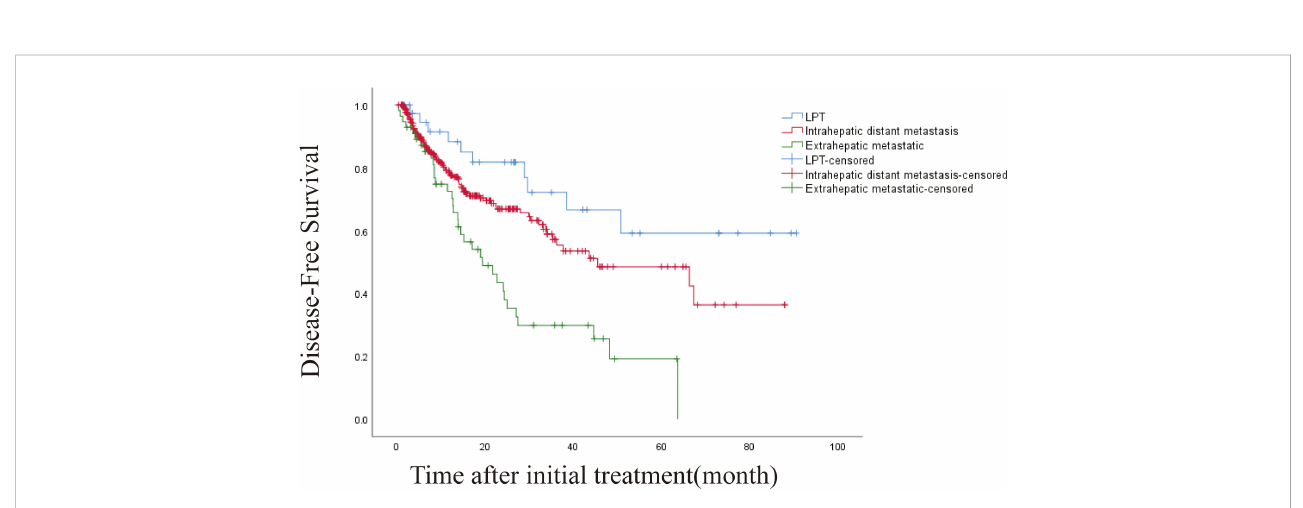
FIGURE 5 Kaplan-Meier curves of disease-free survival (DFS) in patients with LPT, intrahepatic distant metastasis, and extrahepatic metastasis.